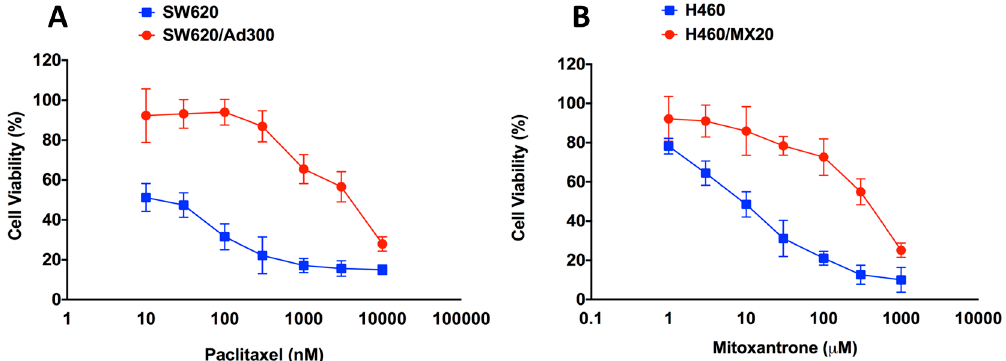
Figure 1. Cytotoxicity of paclitaxel or mitoxantrone in parental and ABCB1- or ABCG2-overexpressing cells. The MTT assay was conducted to determine the e ff ect of paclitaxel on the viability of parental SW620 and ABCB1-overexpressing SW620 / AD300 cells ( A ). The e ff ect of mitoxantrone on the viability of parental NCI-H460 and ABCG2-overexpressing NCI-H460/MX20